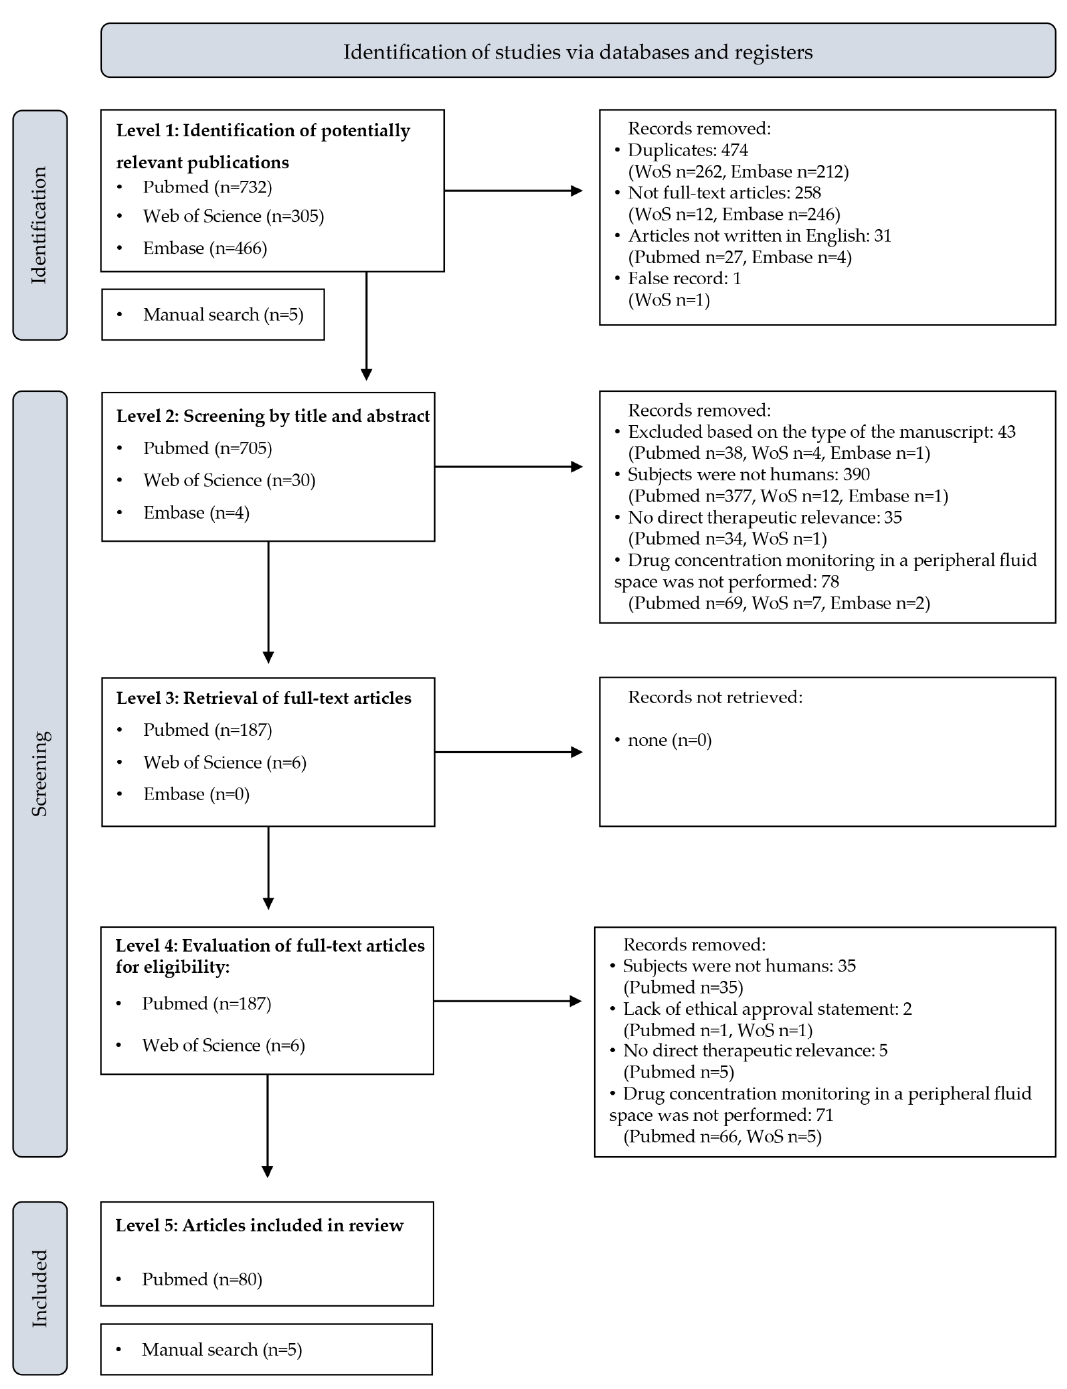
Figure 1. Flowchart of the search strategy and the article selection process. WoS, Web of Science.